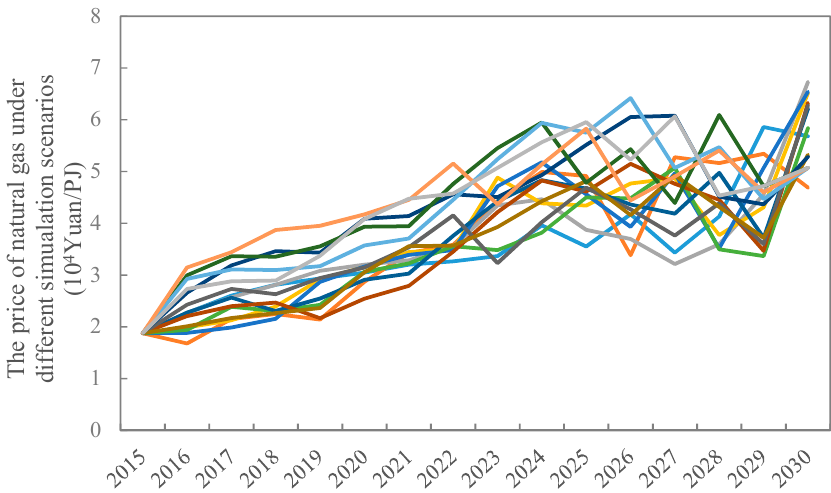
Figure 2. The simulation result of the price of the natural gas.